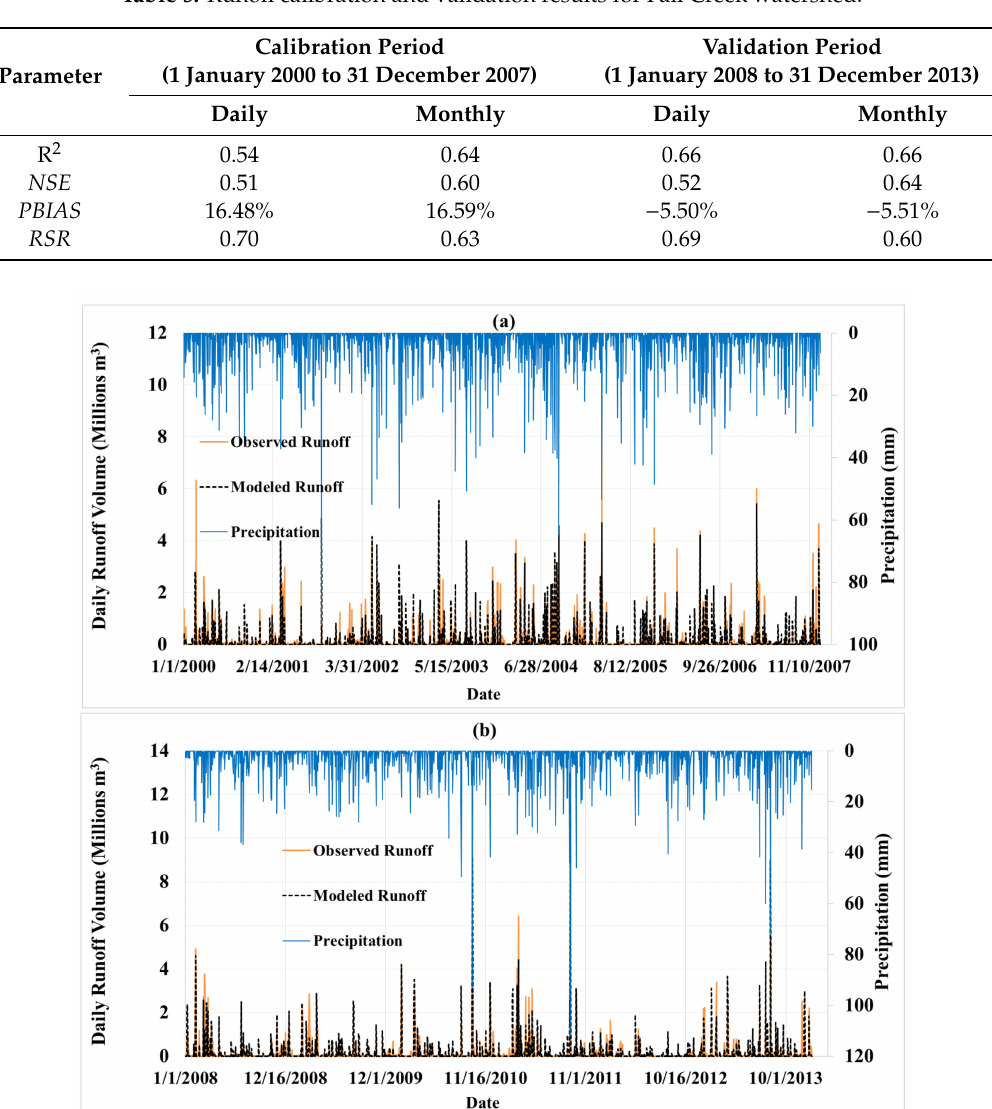
Figure 3. Graphical comparison between daily modeled and observed runo ff after ( a ) after calibration and ( b ) validation phase for Fall Creek